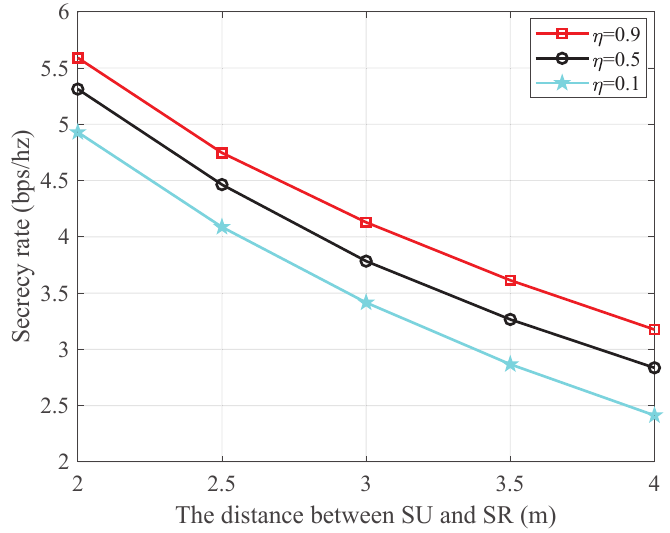
Figure 6. The secrecy rate versus the distance between SU and